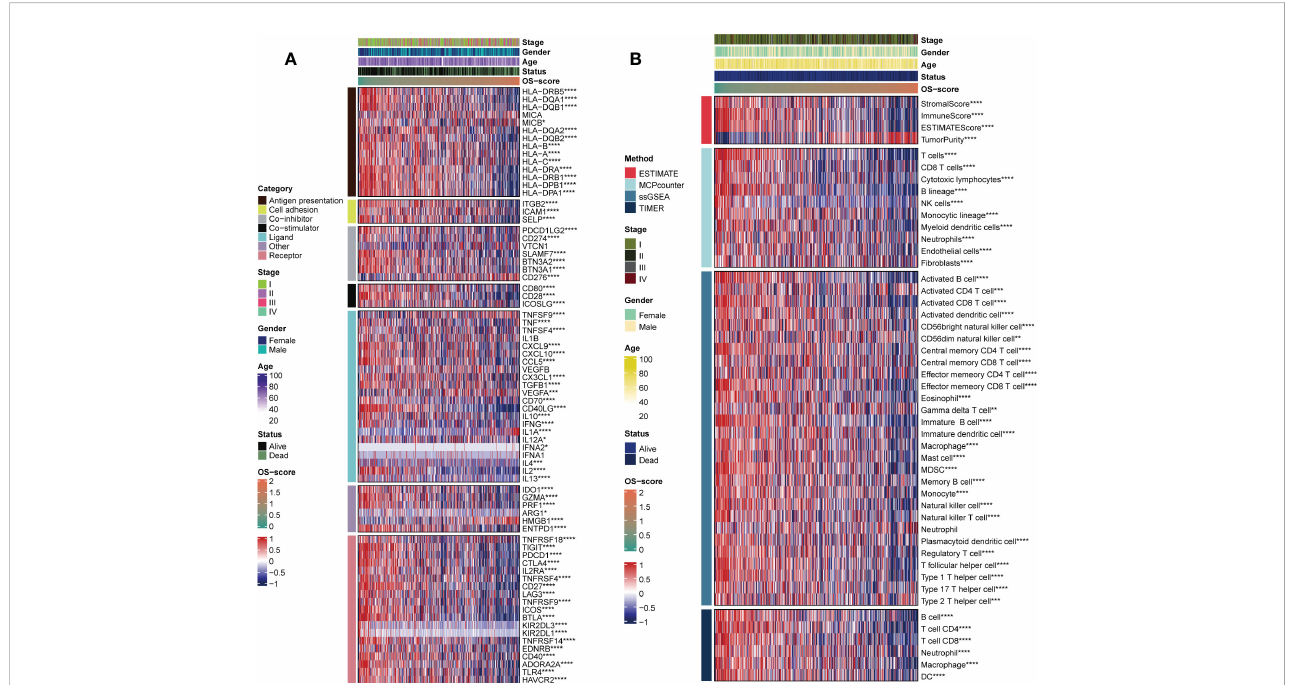
FIGURE 6 Evaluation of immunological characteristics for OS-signature. (A) Correlation of OS-scores with seven immunomodulators in LUAD. Red represents high enrichment score, and blue represents low enrichment score. (B) Heatmap displaying the abundance of in fi ltrating immune cell populations with different OS-scores. *p<0.05, ***p<0.001,